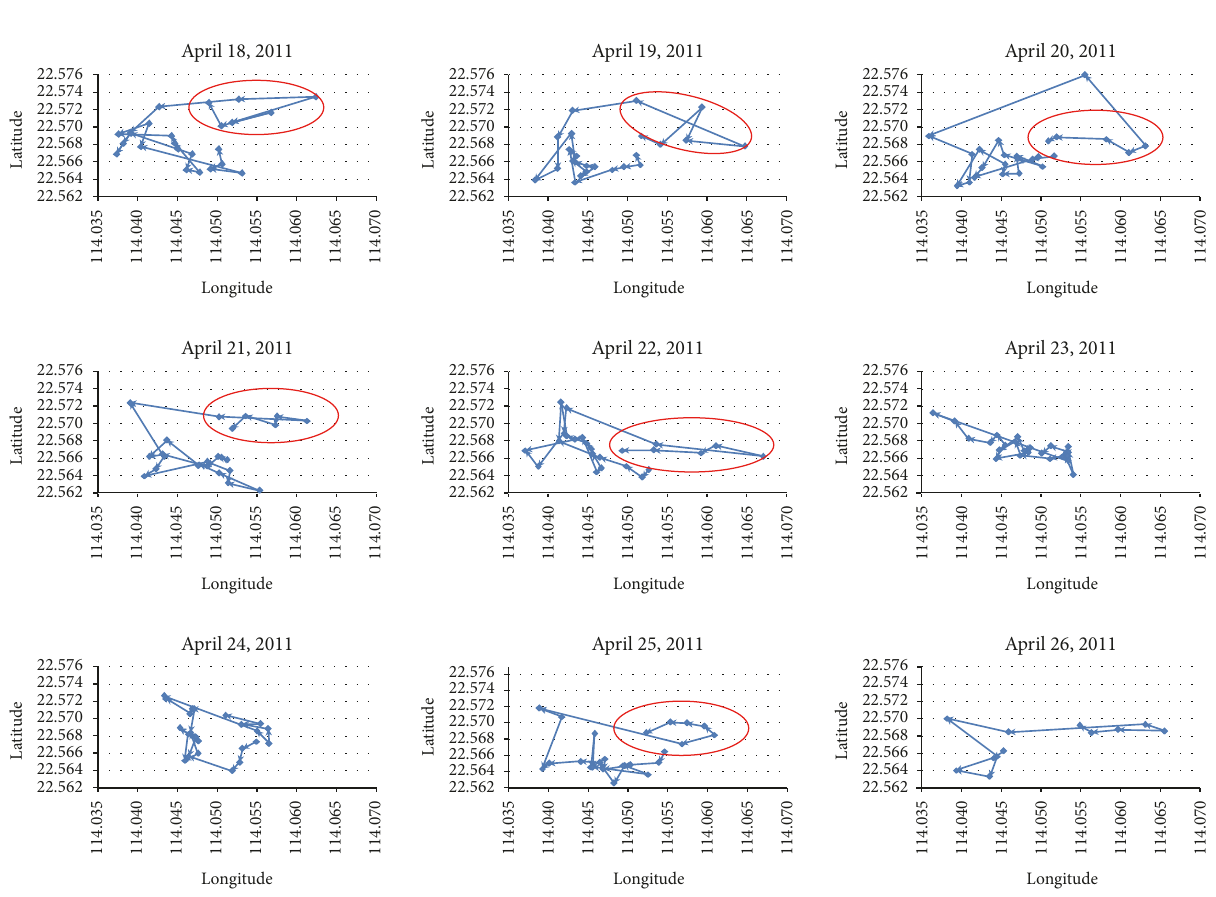
Figure 2: Spatial distribution of taxi driver’s drop-off activity space mean center (from Monday to next Tuesday).